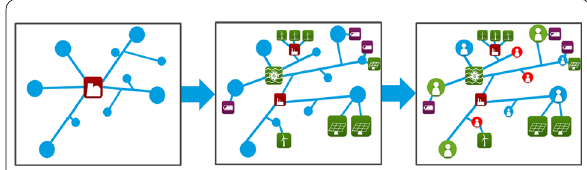
Fig. 1 Multi‑agent systems are a natural paradigm for the control of a decentralized, self‑regulating future energy grid with many contribut‑ ing participants